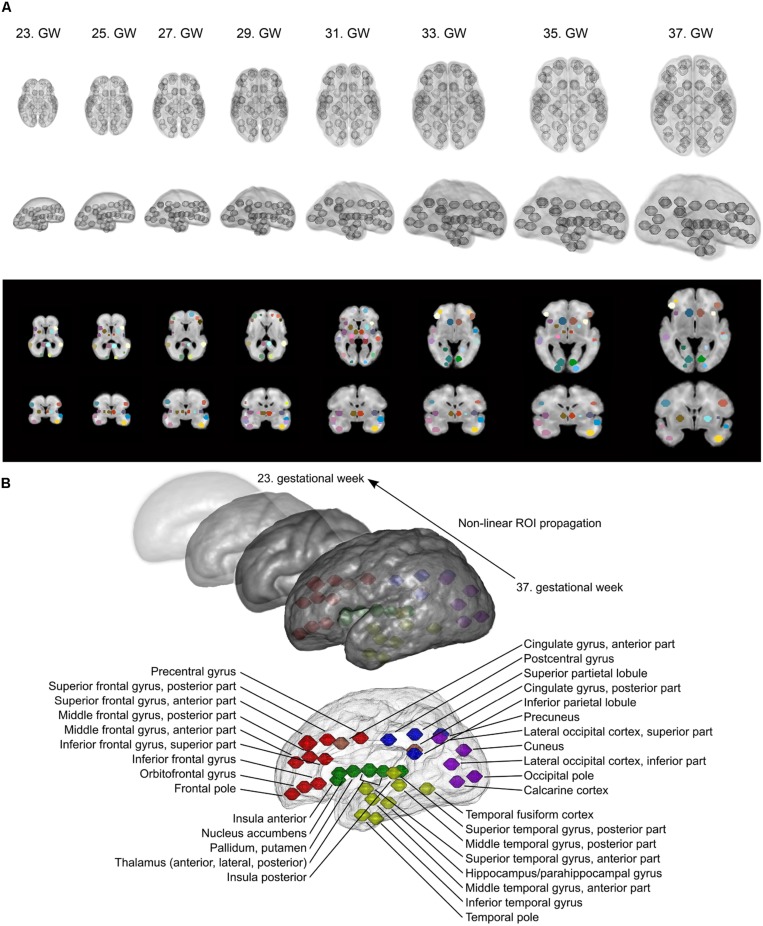
Fetal brain atlas used for fMRI time-course calculation: ROI system and anatomical nomenclature. (A) Illustration of the region propagation procedure. Using high-resolution anatomical templates, we marked 90 anatomically relevant regions on the fetal cortical surface, which was then propagated through the investigated gestational period. Three-dimensional renderings and cross-sectional anatomical images with ROIs are shown. (B) Anatomical nomenclature of the ROI system. Correspondence to major lobes or systems is marked with different colors: red = frontal lobe; blue = parietal lobe; purple = occipital lobe; yellow = temporal lobe; green = subcortical; pink = limbic/cingulate gyrus.